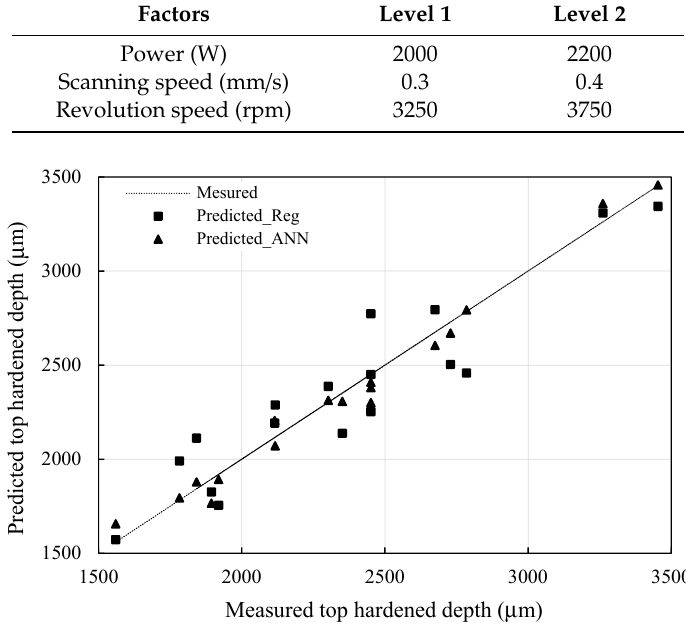
Table 9. Factors and levels for validation.